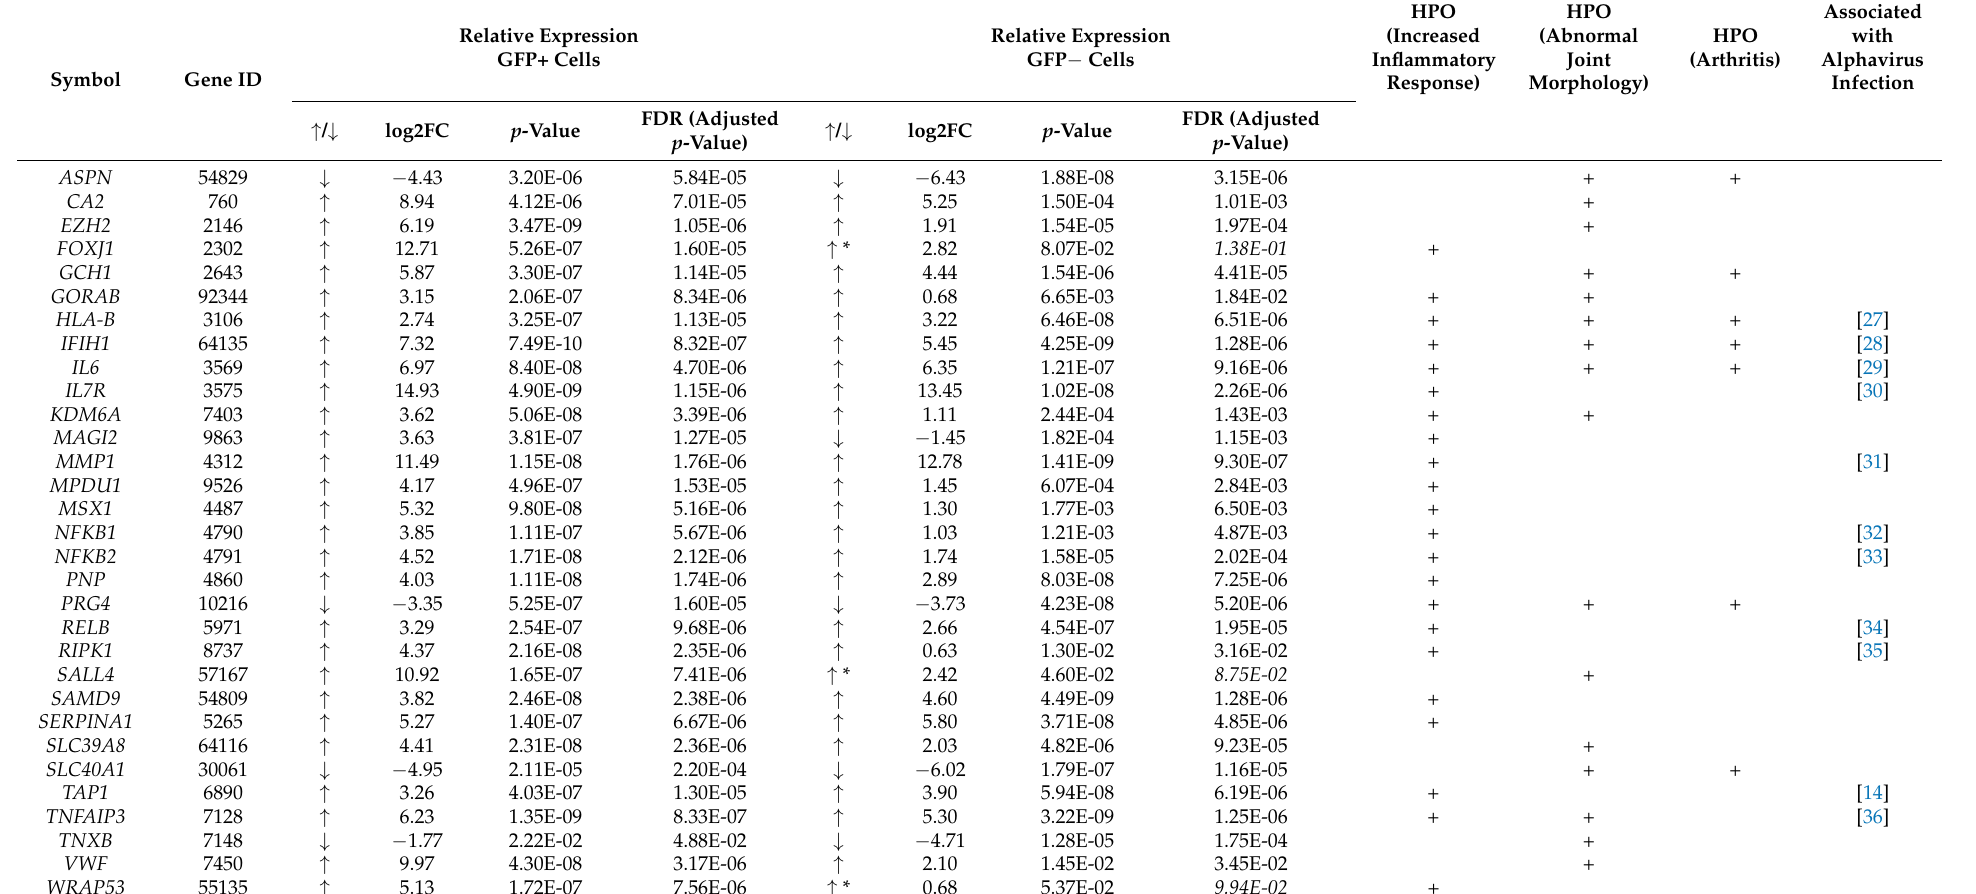
Table 3. Significant DEGs related to joint pathology and their association with alphavirus